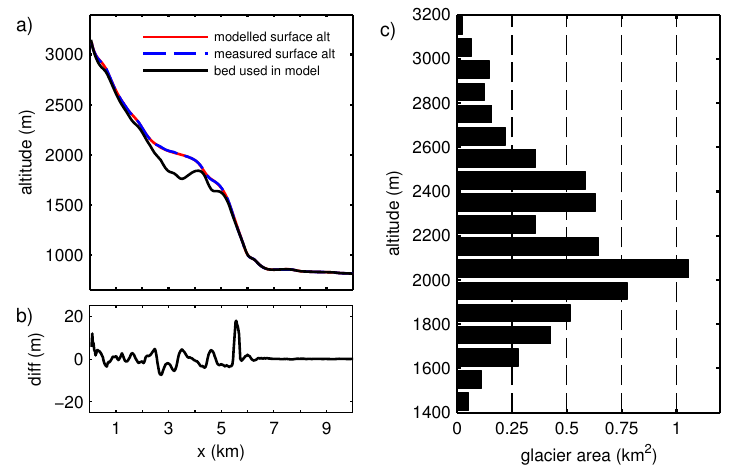
Fig. 2. (a) Surface altitude along the glacier flow line (dashed blue) from the DEM. For 0 <x < 5.6km, the DEM gives the ice surface altitude instead of the bed altitude. Here, the bed profile (black) is determined with the ice flow model. The modelled glacier surface is shown in red. (b) Difference between modelled and observed surface altitude. The difference is less than 10m except for 5.6 <x < 5.7km, where there is ice in the model run (whereas in 2000 the terminus was at x ≈ 5.6km). (c) Elevation distribution of the 2009 glacier area in 100m intervals as derived from the 2000